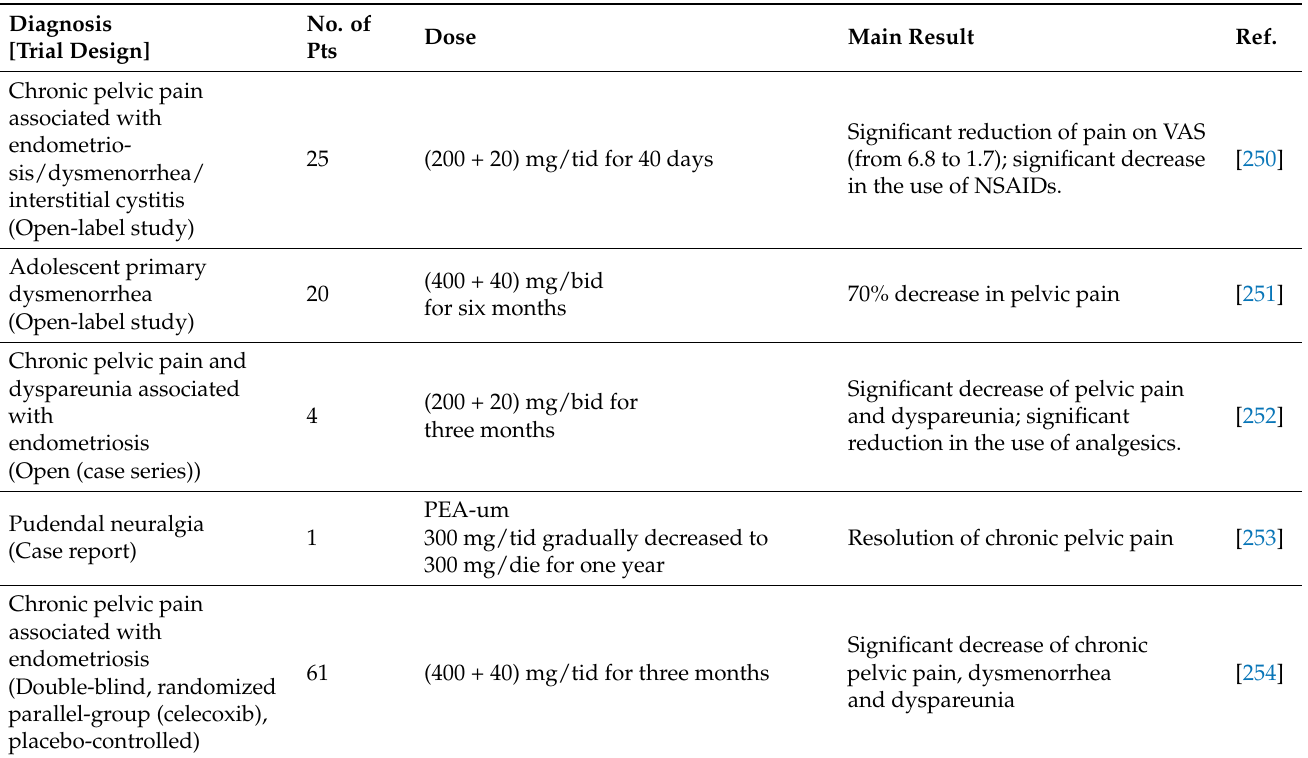
Table 7. Pain relieving effect of PEA-Pol (i.e., PEA co-micronized with the antioxidant polydatin in 10:1 ratio) on chronic pelvic pain: overview of clinical trials in chronological